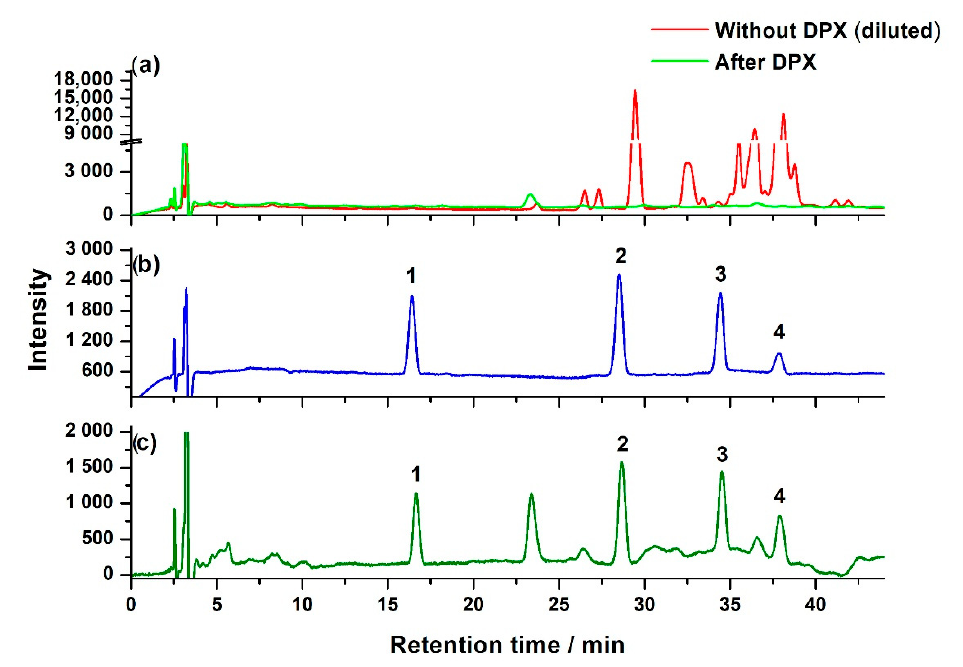
Figure 1. Representative chromatogram of ( a ) diluted SALLE extract without DPX and SALLE extract after PSA-based DPX, ( b ) standards of neonicotinoid pesticides and internal standard, ( c ) spiked bee pollen sample after SALLE and following PSA-based DPX clean-up. Peak 1: thiamethoxam, 2: acetamiprid, 3: thiacloprid, and 4: ethyl 6-chloropyridine-2-carboxylate (internal standard).